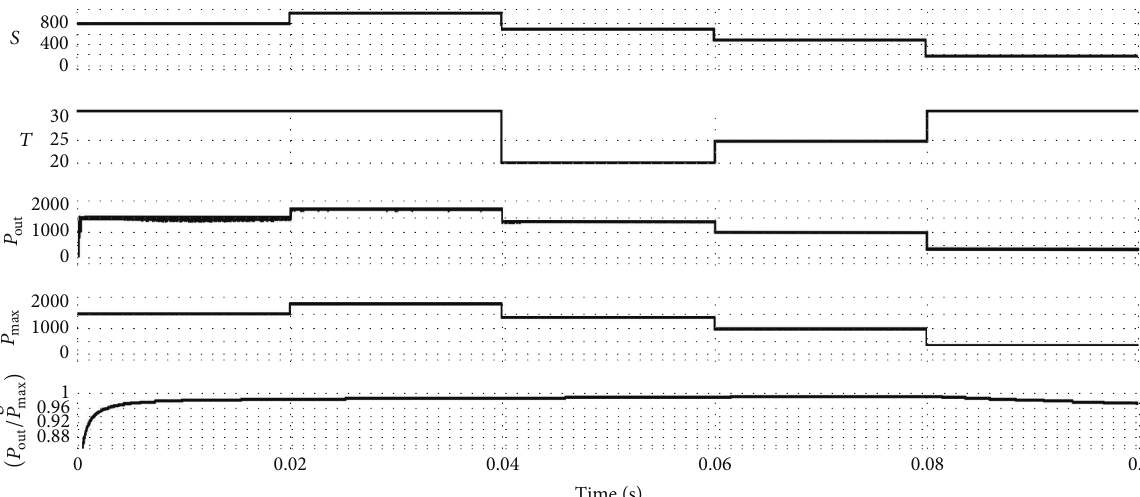
Figure 11: Irradiance profile ( 𝑆 ), temperature profile ( 𝑇 ), extracted power ( 𝑃 and average efficiency obtained with IC